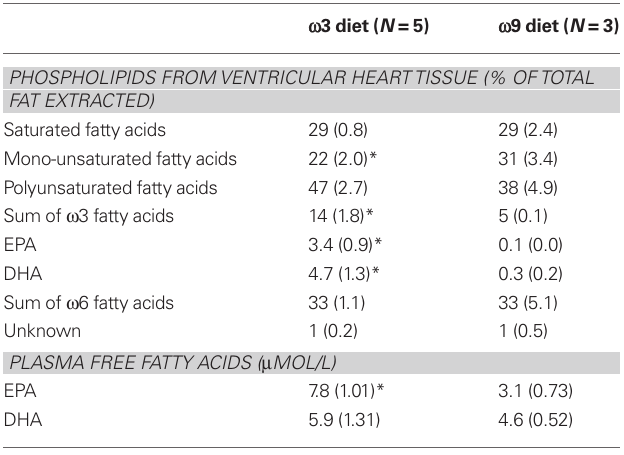
Table 1 | Phospholipid composition of the heart (% of total fat extracted) and plasma free fatty acid